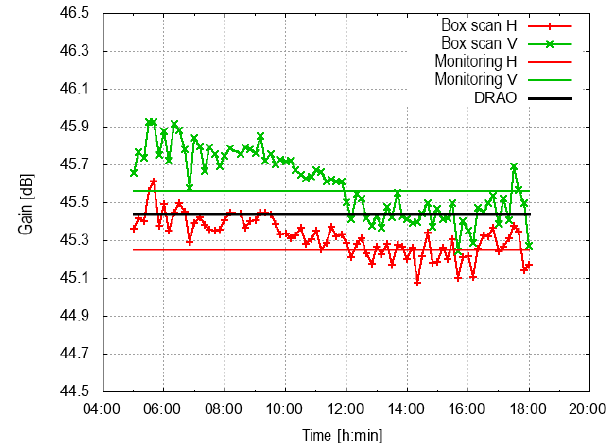
Figure 12. Antenna gain time series in H and V during 15 June 2018 (UTC). Also shown is the antenna gain estimate from operational monitoring (monitoring H, monitoring V) and the gain estimate us- ing DRAO data